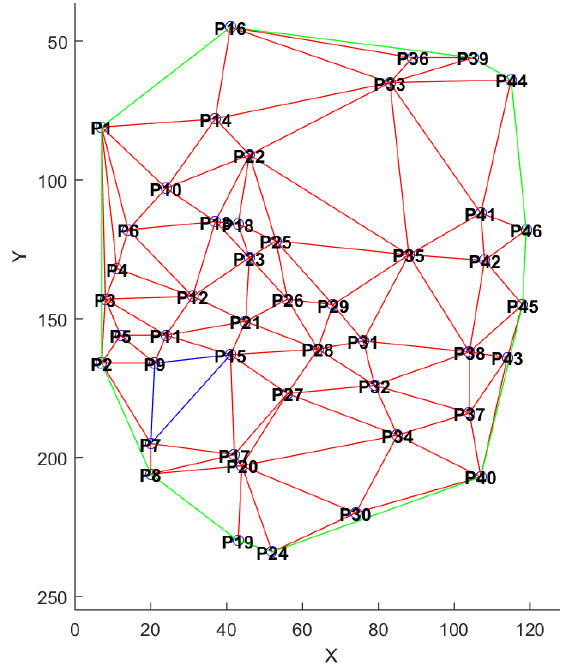
Figure 8. Example of Delaunay triangulation of a minutiae template (source